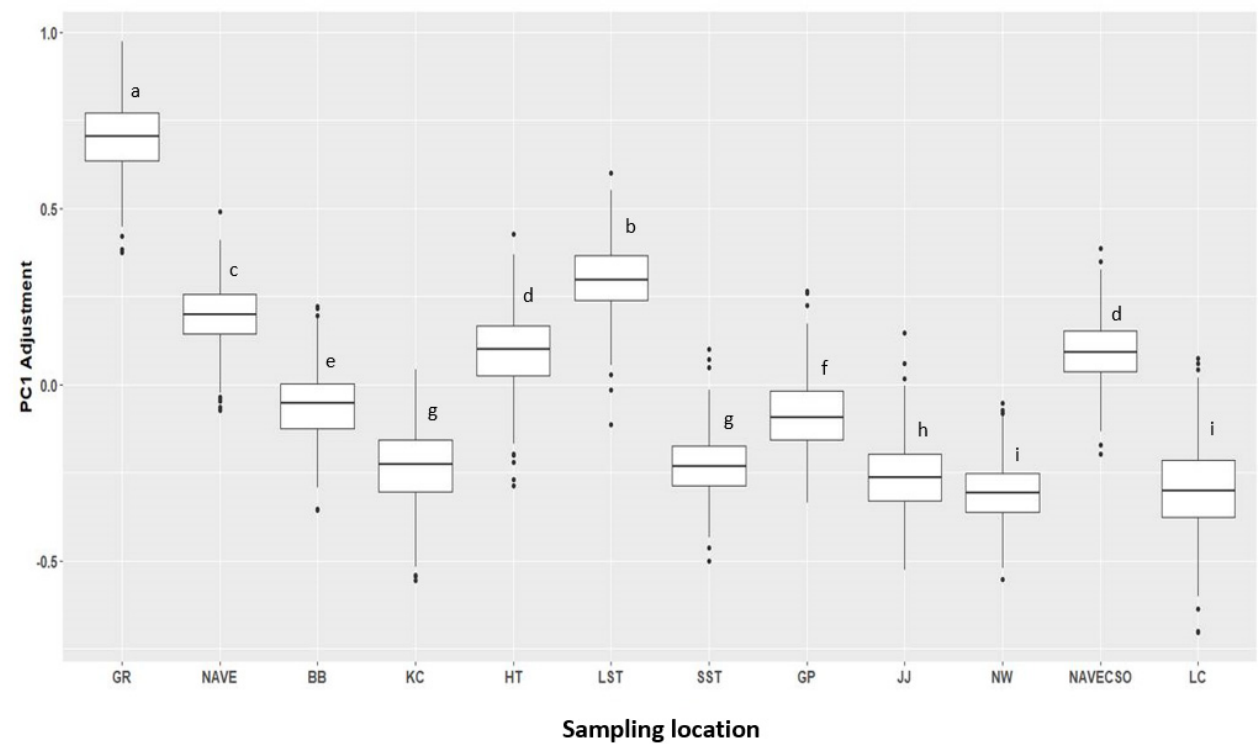
Figure 6. Partial Dependence Plot showing the influence of sampling locations on ARG abundance, as represented on the y-axis by the PC1 scores. Sampling locations are arranged following a gradient of high to low human fecal input from GR to LC. Different letters on boxplots represent significant differences whilst similar letters show no differences.